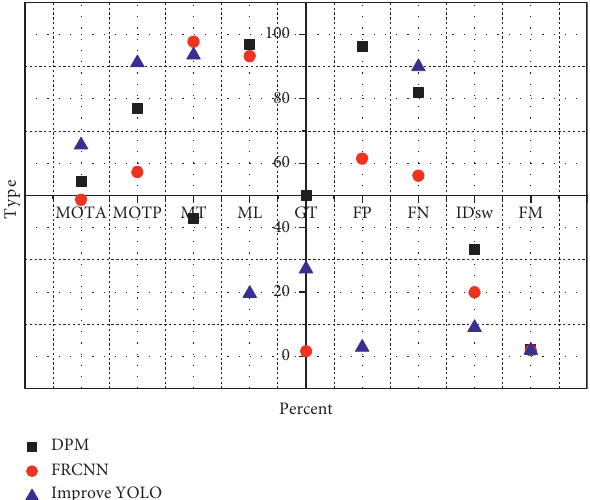
Figure 5: Comparison of motion multiobjective tracking result indicators with different detection